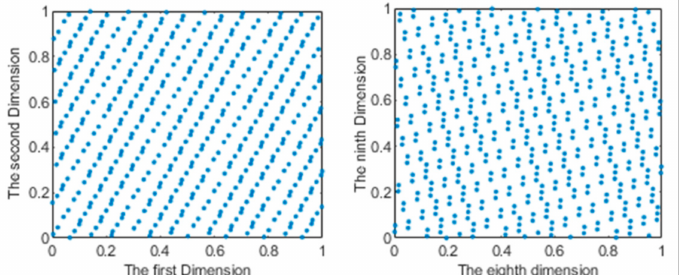
Figure 2. Uniformity of the two-dimensional distribution of sample points by the GP split-circle domain